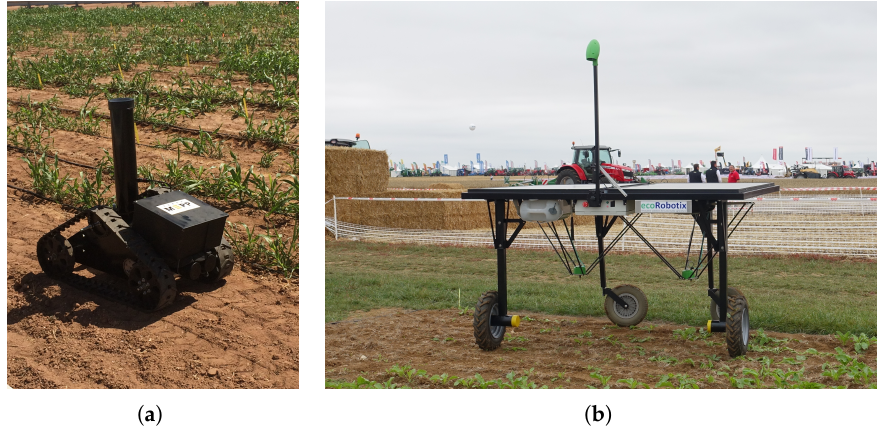
Figure 6. Terra-Mepp ( a ) and EcoRobotix ( b ) robots in the field